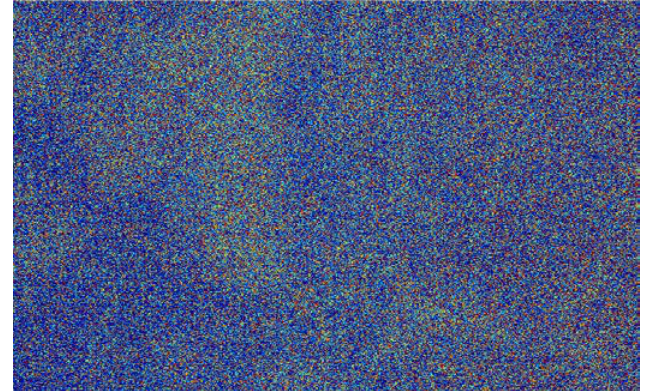
Figure 4. Second derivative at 545 nm for the Red Sea dataset reported in false